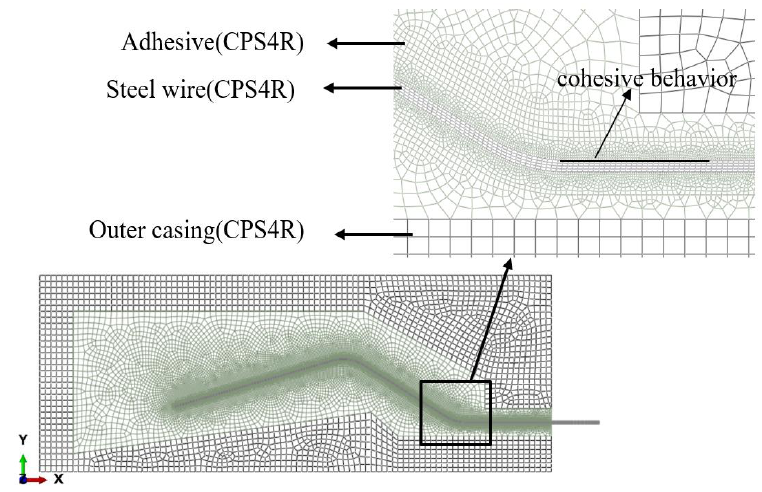
Figure 8. Mesh and element type of FE model.